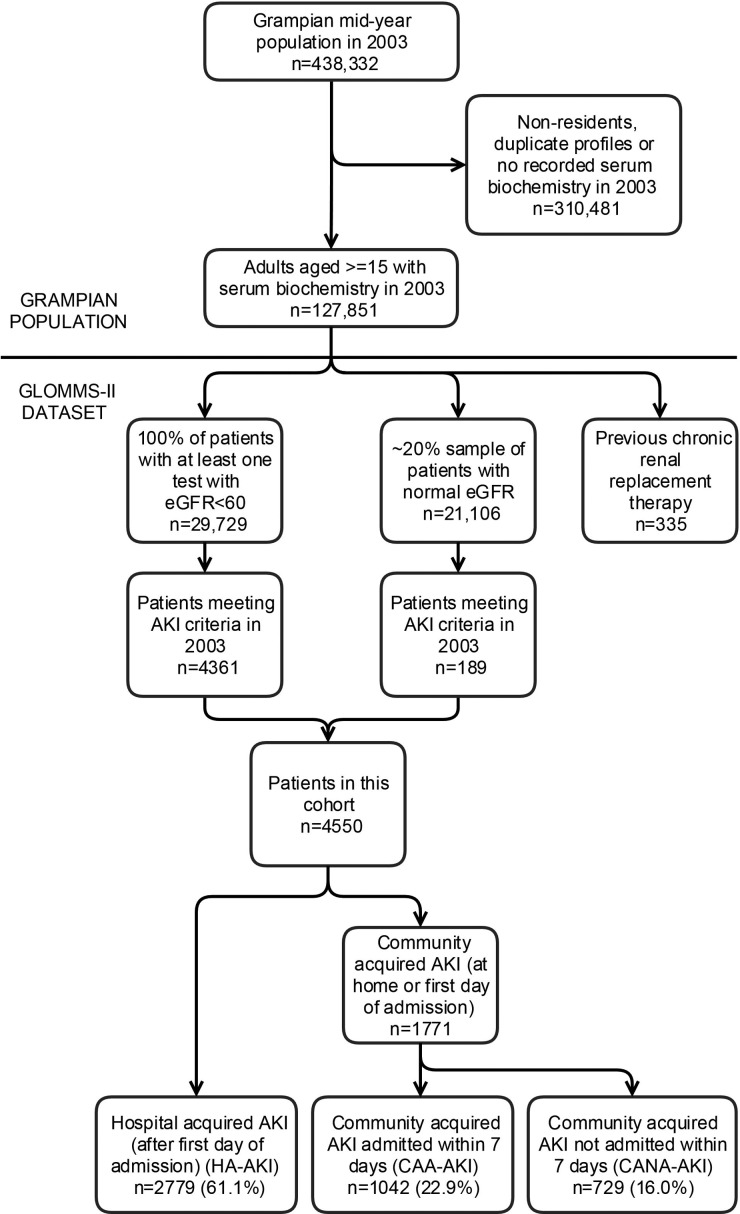
Flowchart of GLOMMS II cohort including AKI subgroups. AKI, acute kidney injury; HA-AKI, hospital AKI; CAA-AKI, community AKI admitted within 7 days; CANA-AKI, community AKI not admitted within 7 days. In sensitivity analysis, the proportions after multiplying out the sampled fraction were 61.0% HA-AKI, 22.1% CAA-AKI and 16.8% CANA-AKI.